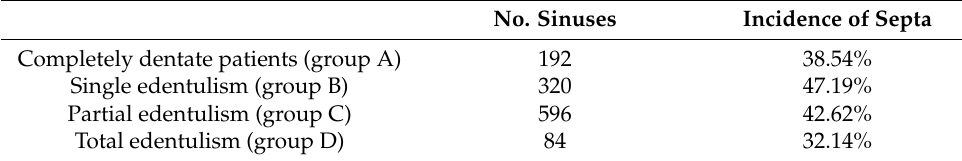
Table 1. The incidence of sinus septa in different type of edentulism. No. Sinuses Incidence of Septa Completely dentate patients (group A) 192 38.54% Single edentulism (group B) 320 47.19% Partial edentulism (group C) 596 42.62% Total edentulism (group D) 84 32.14%